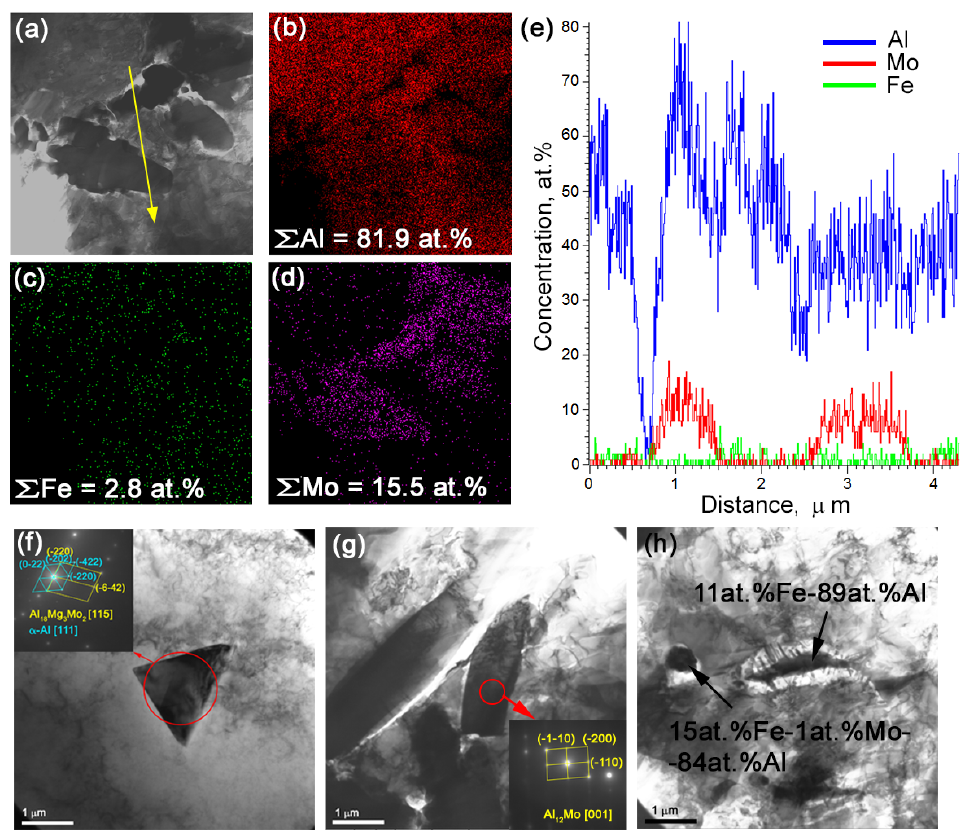
Figure 9. Bright-field TEM image ( a ) and EDS maps ( b – d ) of zone 2 microstructures obtained with 0.6 g/layer Mo. EDS profile along the line in Figure 8a ( e ), and TEM images of IMCs ( f – h ). For samples obtained with Mo loads of 0.9 and 1.2 g/layer, it becomes observable that the volume content of Mo-rich particles is reduced (Figures 10 and 11) with simultaneous increasing of the areas occupied by Al-Mo IMCs (Figures 10d and 11c,e). Mo-rich particles containing 1.6–7.6 at.% Al were detected (Figures 10d and 11c, Tables 5 and 6, spectrum 1) that were encompassed with the light-grey Al 8 Mo 3 shells (~46–62 at.% Al, ~38–54 at.%